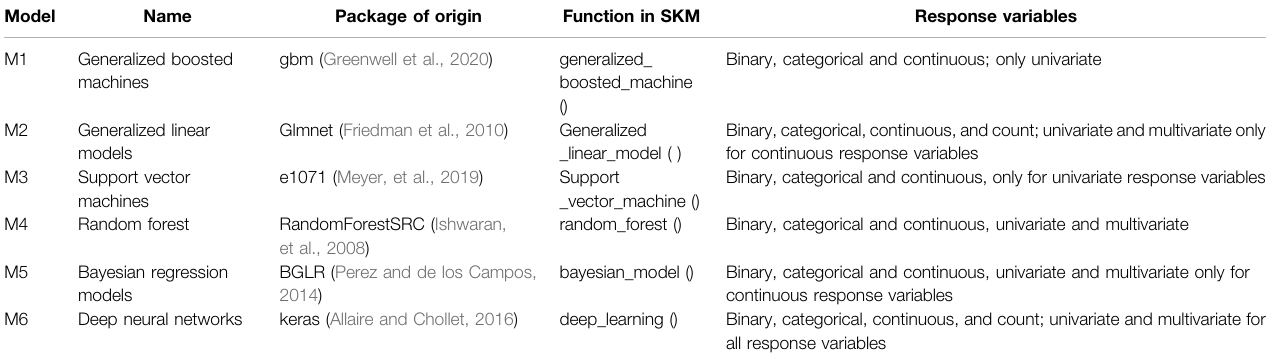
TABLE 1 | Models that can be implemented in the SKM